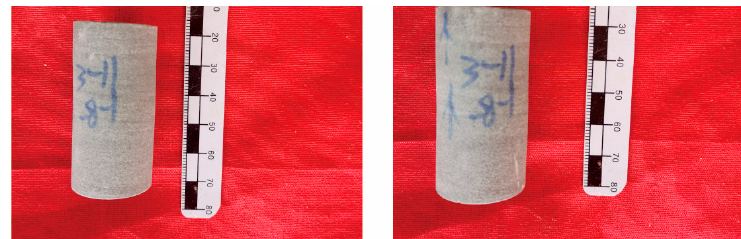
Figure 4. The core before and after the experiment.